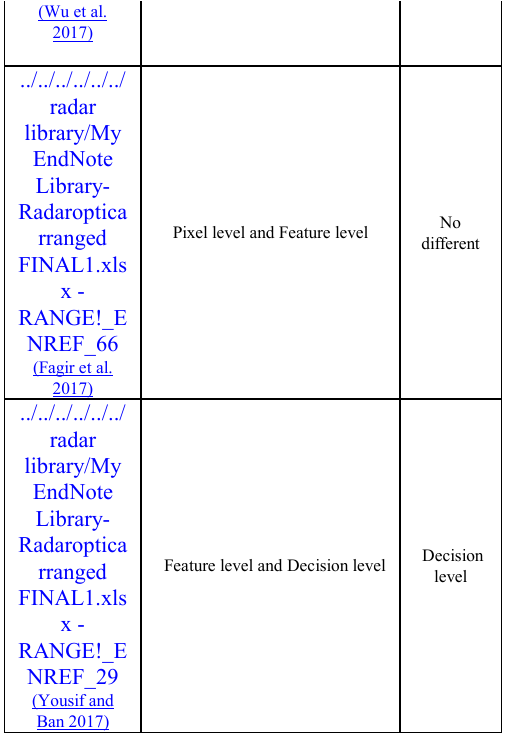
Table 6: Conclusion and comparison of processing